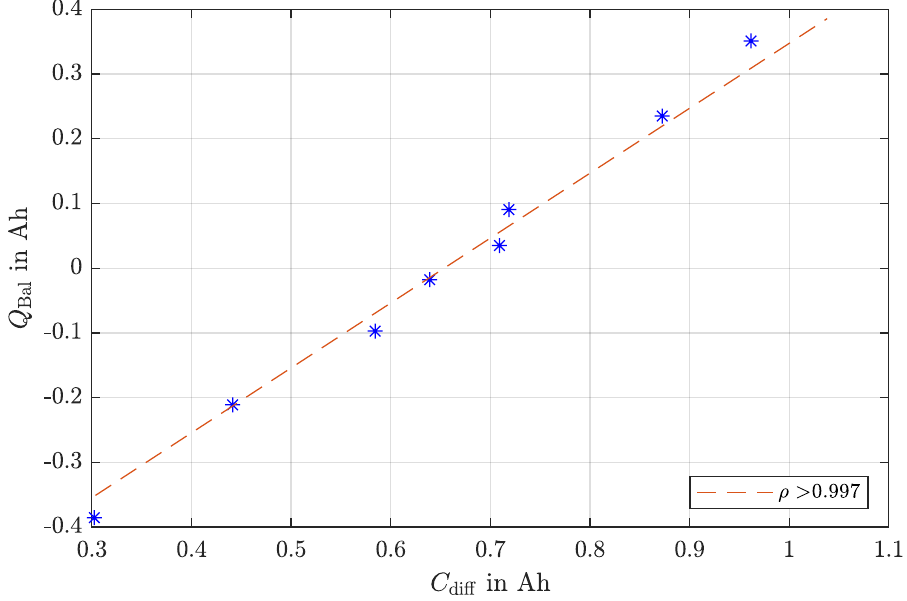
Figure 9. Correlation between balancing charges of the active balancing algorithm and the capacity losses of the 8 cells with the corresponding Pearson correlation